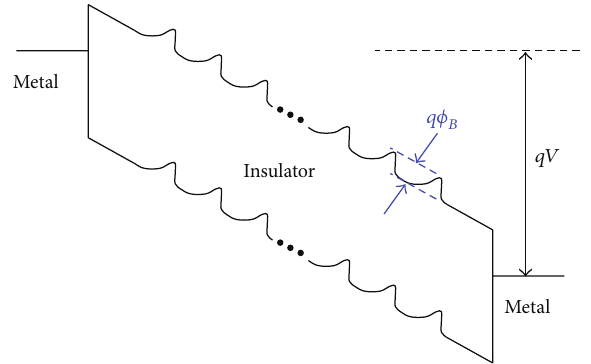
Figure 30: Schematic energy band diagram for grain-boundary- limited conduction in metal-insulator-metal